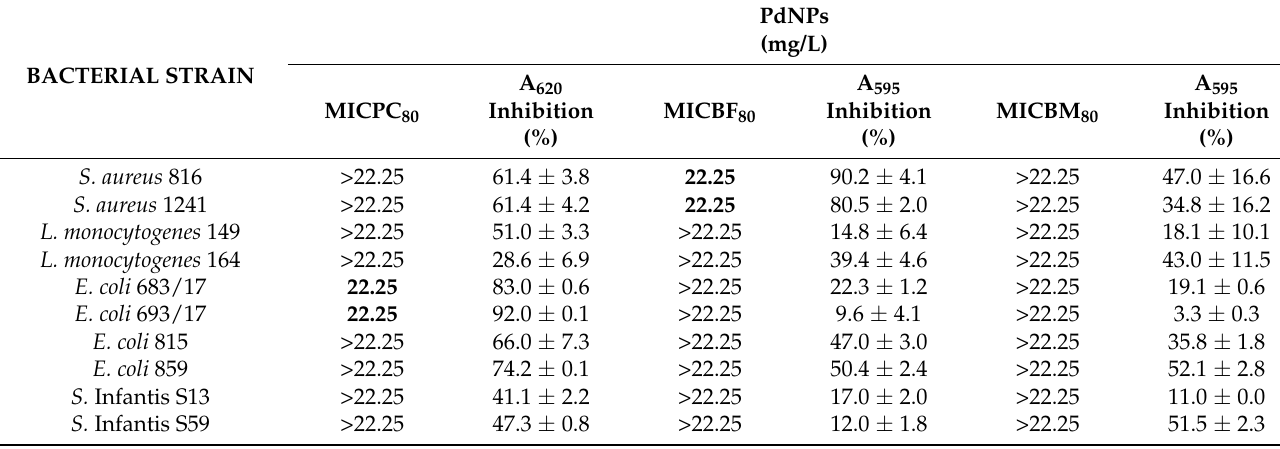
Table 1. Minimal concentrations inhibiting planktonic growth, biofilm formation and biofilm metabolic activity with their respective inhibitory rates of PdNPs for planktonic cells. Data represent the mean of at least three independent replicates. The significance of the results was verified by t -test ( p ≤ 0.05).